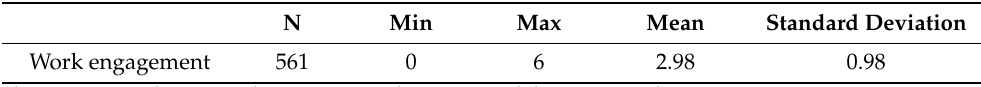
Table 4. Work engagement